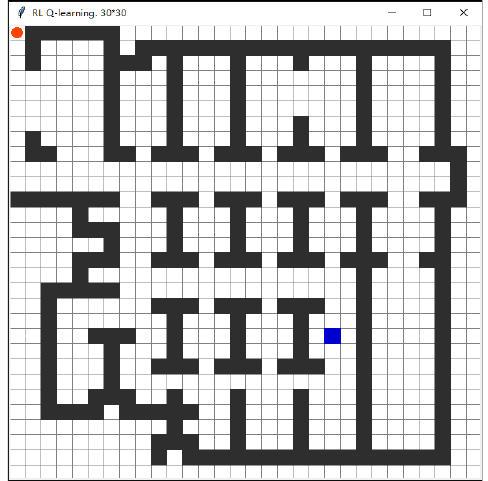
Figure 9. No fire simulation environment.